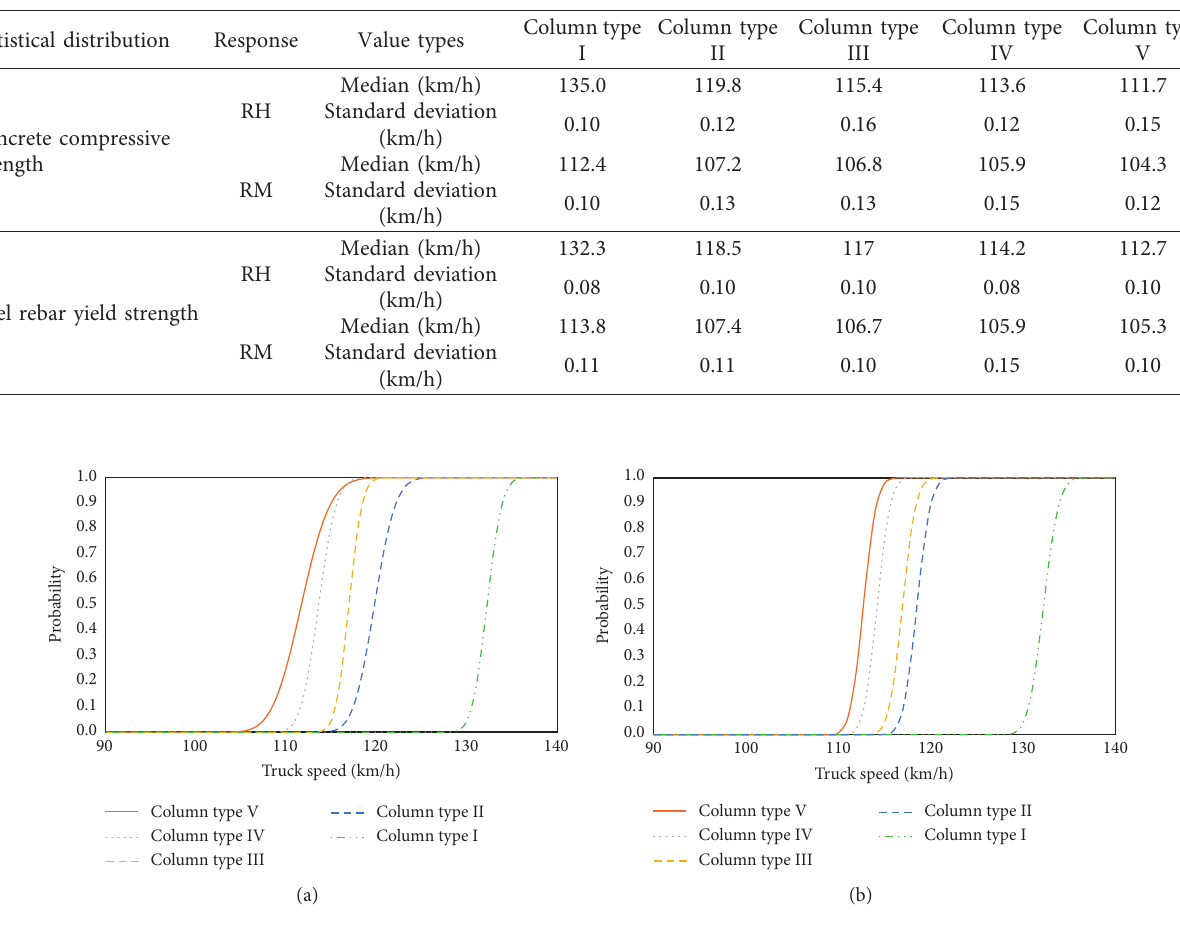
Figure 15: Fragility curve of 38-ton truck-bridge column collision for response high (RH). (a) Concrete compressive strength. (b) Steel rebar yield strength.